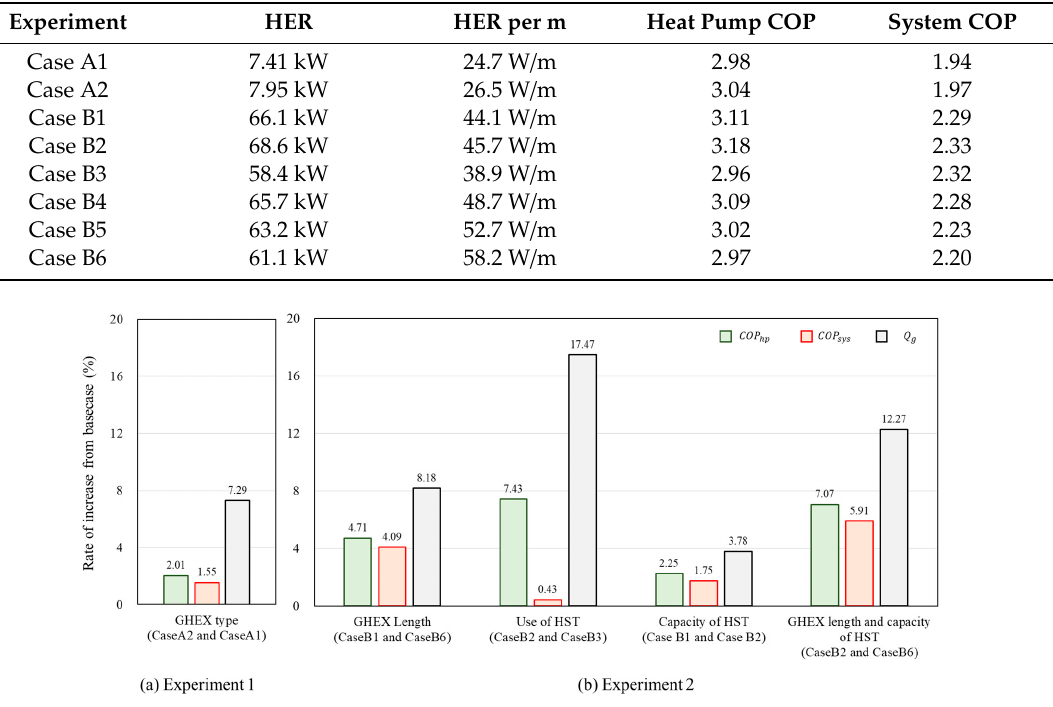
Table 4. Result of GSHP performance according to design factor.